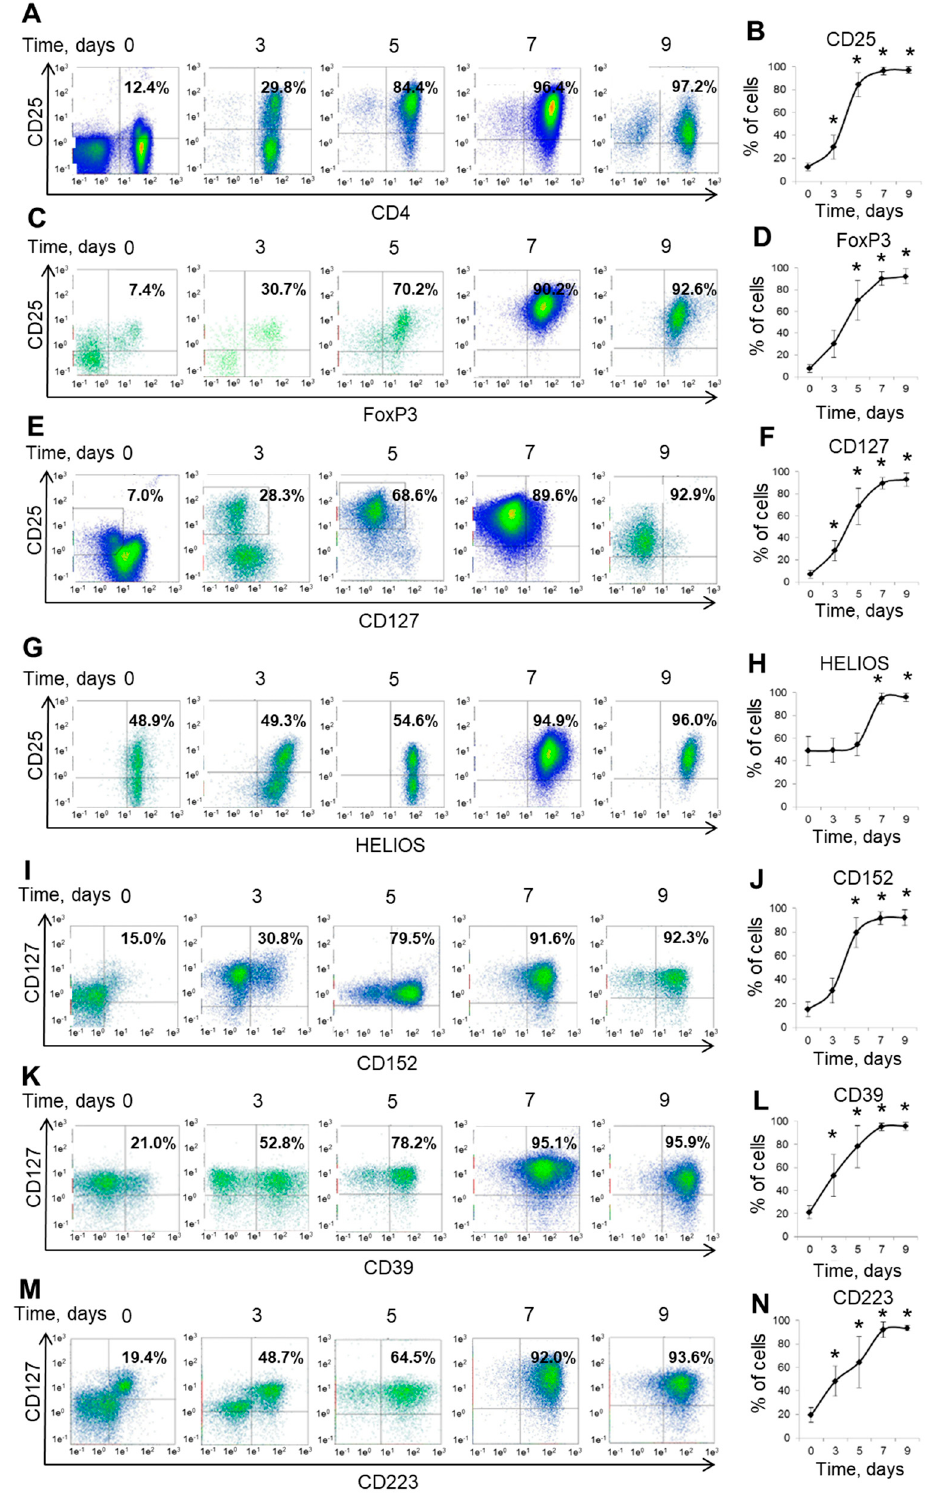
Figure 2. The expression of Treg markers reached a maximum ratio at day seven of ex vivo expansion. Initial CD4 + cells were cultured for 9 days to develop eTregs. Representative flow cytometry diagrams for cells labeled with the following antibodies: ( A ) CD25, ( C ) FoxP3, ( E ) CD127, ( G ) Helios, ( I ) CD152, ( K ) CD39, ( M ) CD223. ( B , D , F , H , J , L , N ) Mean expression of markers within the time of expansion. N = 5. * p ≤ 0.05 vs. initial cells at the 0-day time-point, measured by Bonferroni modification of Student’s t -test. 1×10